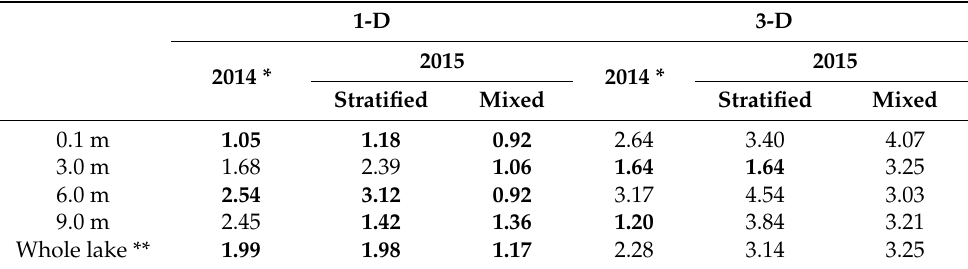
Table 3. The root mean square errors (RMSEs) of the predicted temperatures (in ◦ C) at different depths for 2014 and 2015. The lower RMSEs between the 1-D and 3-D model results for both stratified and mixed conditions are shown in bold.